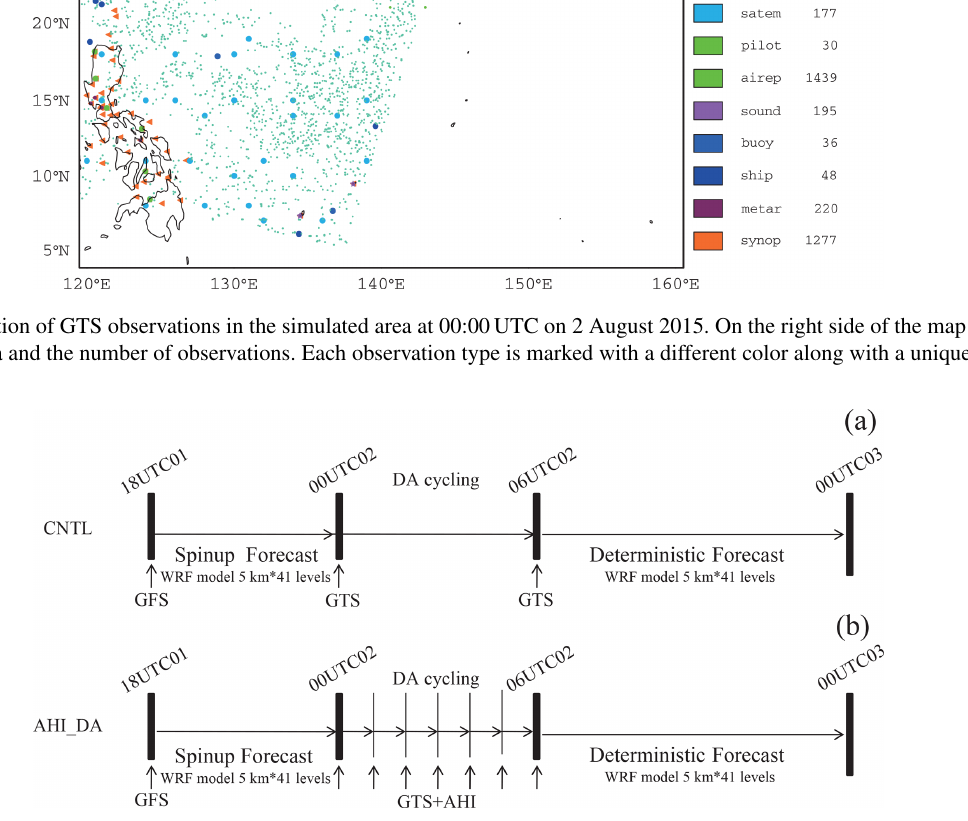
data assimilation at 00:00 UTC on 2 August 2015. The 6